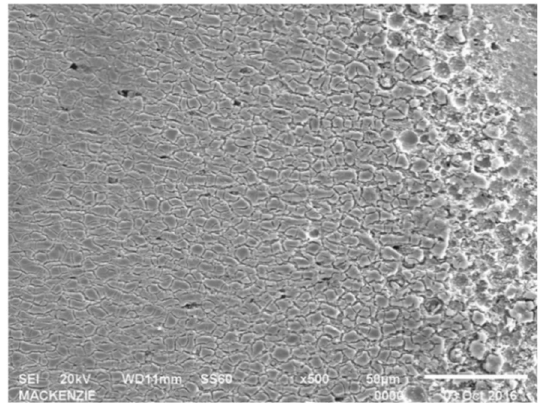
Figure 11. Micrograph of the longitudinal section of the Inconel 625 fracture region tensile tested at 800 °C showing equiaxial grains.